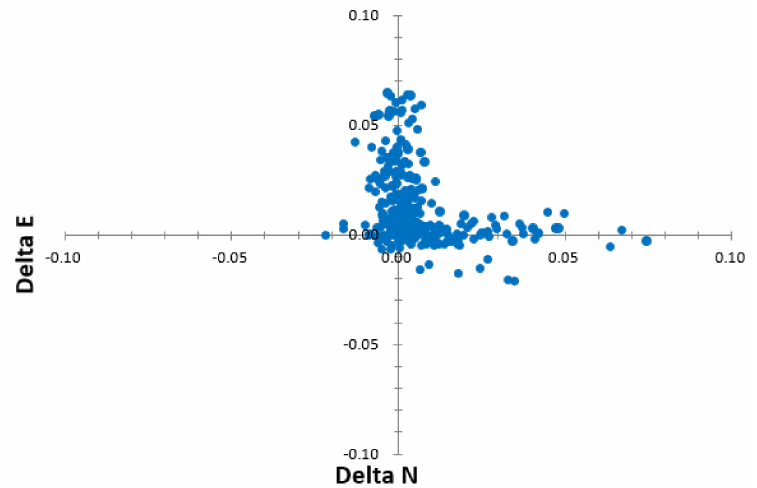
Figure 3. Deviation distribution of the large rectangle (red rectangle in Figure 2) with TTS logging rate = 0.5 s